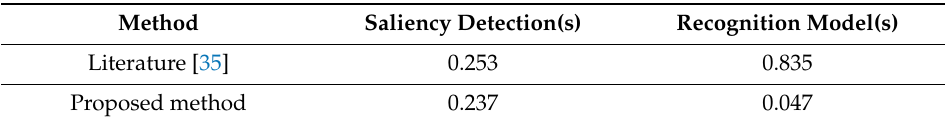
Table 5. Running times of each